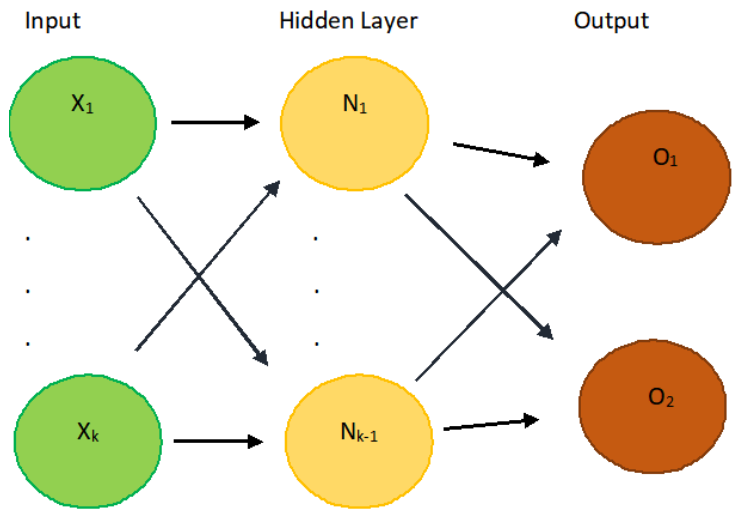
Figure 4. Deep learning neural network (DNN) outline.